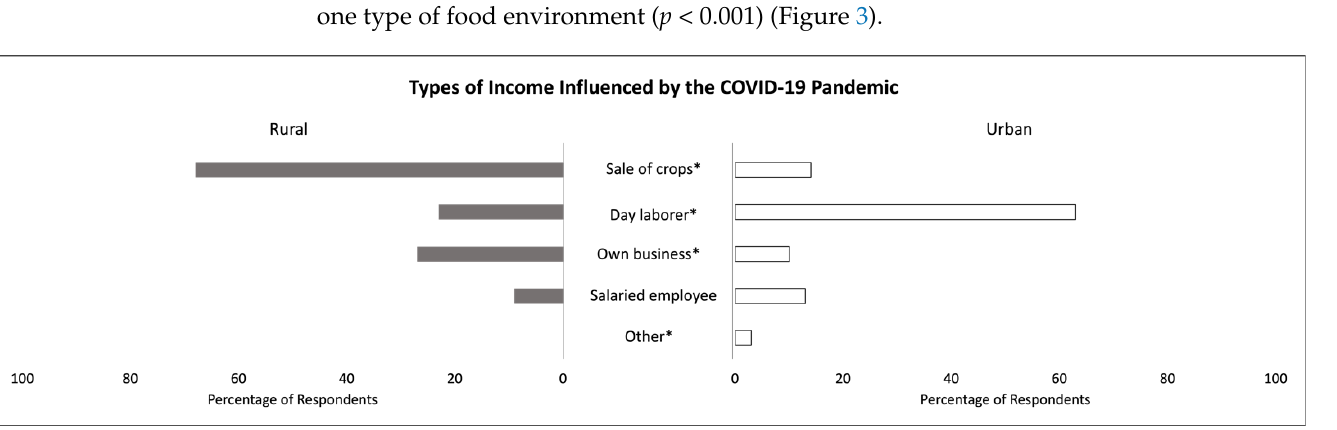
Figure 2. Reported impact of COVID-19 on various income sources in urban ( n = 144) and rural ( n = 173) Kenya. Multiple responses were recorded. * Statistically significant at p < 0.05 ( χ 2 test). Table 2. Reported change in access to food sources in rural and urban Kenya.